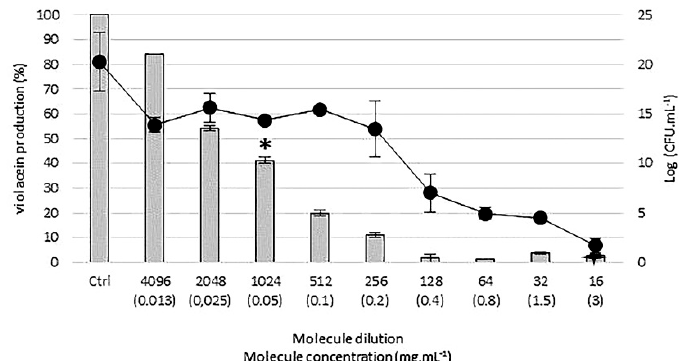
Figure 2. Effect of increasing molecule concentrations on Chromobacterium violaceum growth ( ) and violacein production ( and MQSIC